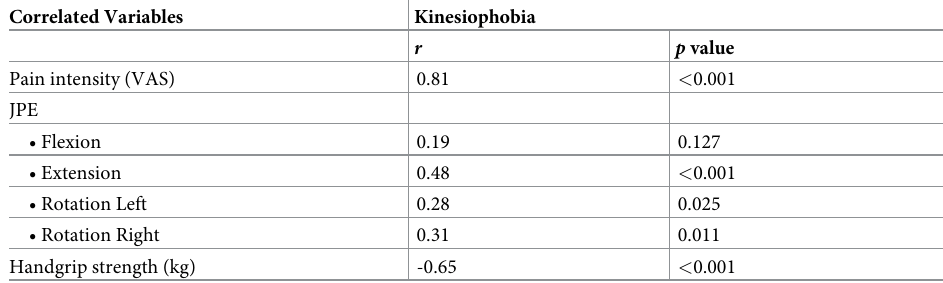
Table 2. Relationship between kinesiophobia, pain intensity, functional performance, and proprioception ( n =